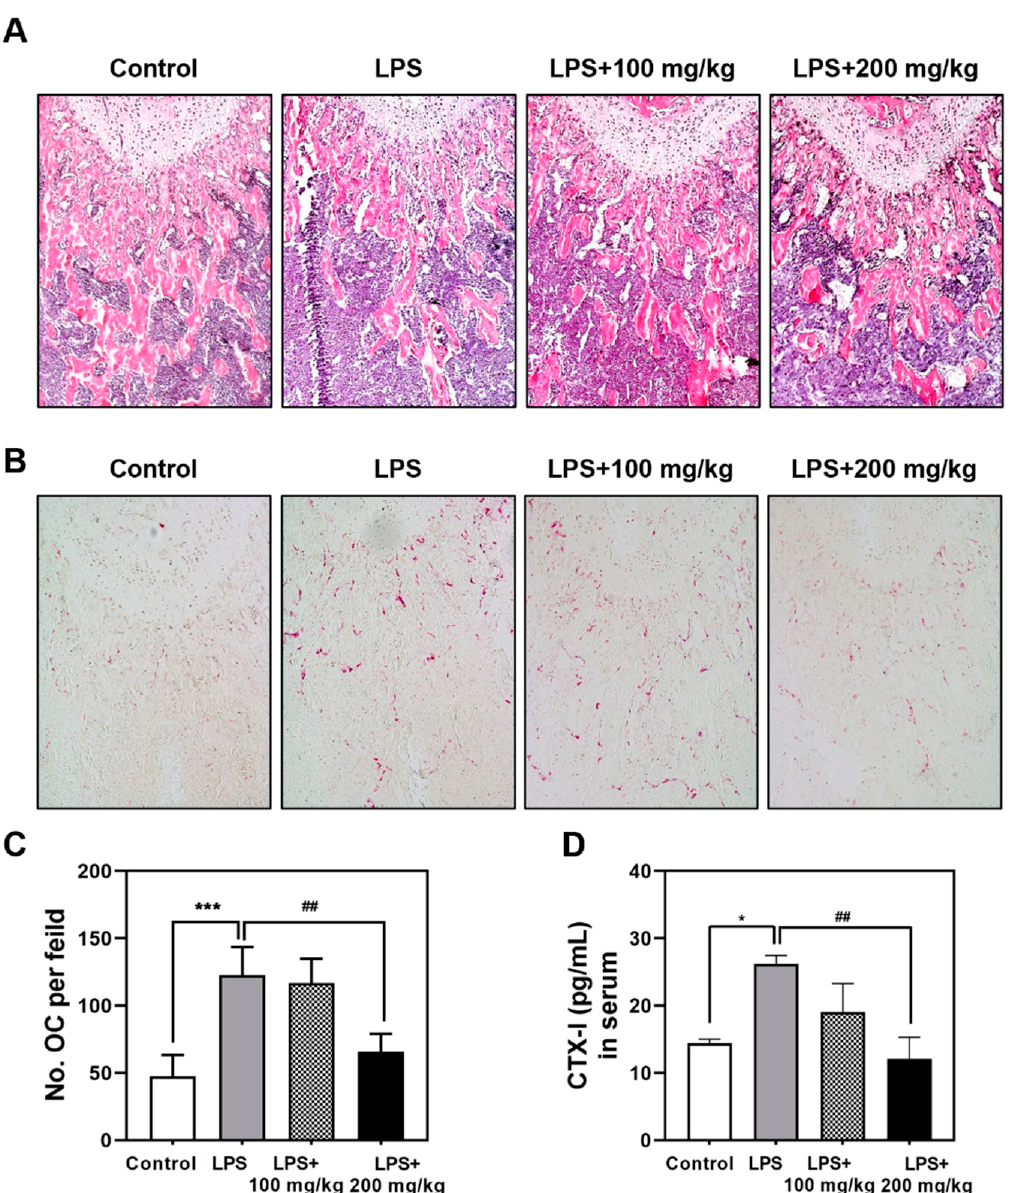
Figure 2. Vigeo inhibits lipopolysaccharide (LPS)-induced osteoclast activation in mice. ( A ) LPS injected mice were sacrificed after 9 days, and dissected femurs were fixed, decalcified, paraffin-embedded, and sectioned. The slices were stained with hematoxylin and eosin (H&E). ( B ) Slices stained with tartrate-resistant acid phosphatase (TRAP). ( C ) The number of osteoclasts per visual field of tissue was measured by histomorphometric analysis. ( D ) Blood samples were collected from mice and centrifuged to obtain serum for the evaluation of CTX-I levels by ELISA. Statistical analysis was performed using one-way analysis of variance (ANOVA) followed by Tukey’s posthoc test for comparisons among the three groups. * p < 0.05, *** p < 0.001 versus the control group; ## p < 0.01 versus the LPS group.